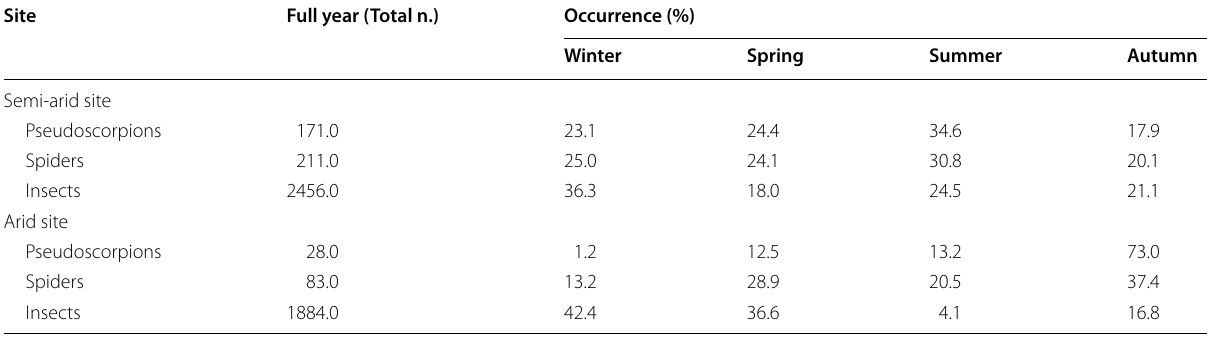
Table 2 Seasonal occurrence of insect, pseudoscorpion, and spider fauna in Thymelaea hirsuta samples in two different natural habitats, in 1990 Site Full year (Total